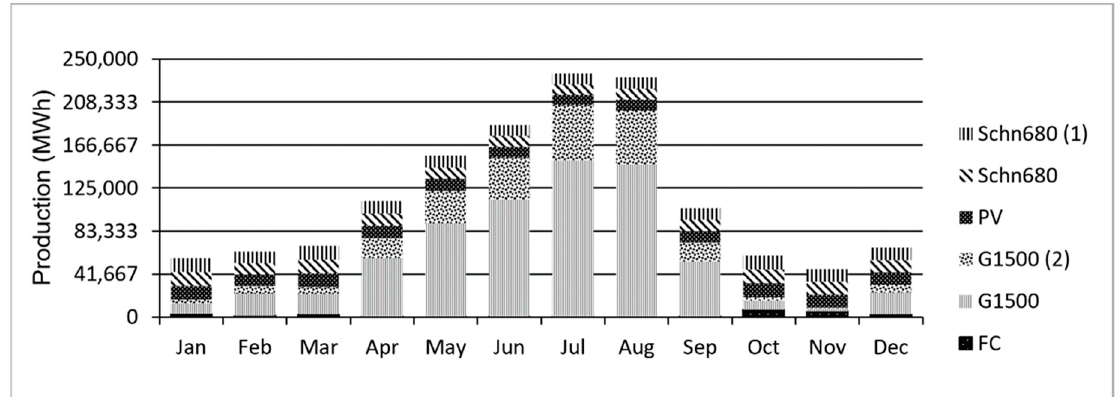
Figure 13. Monthly electric energy production of wind-PV-FC-Battery system.